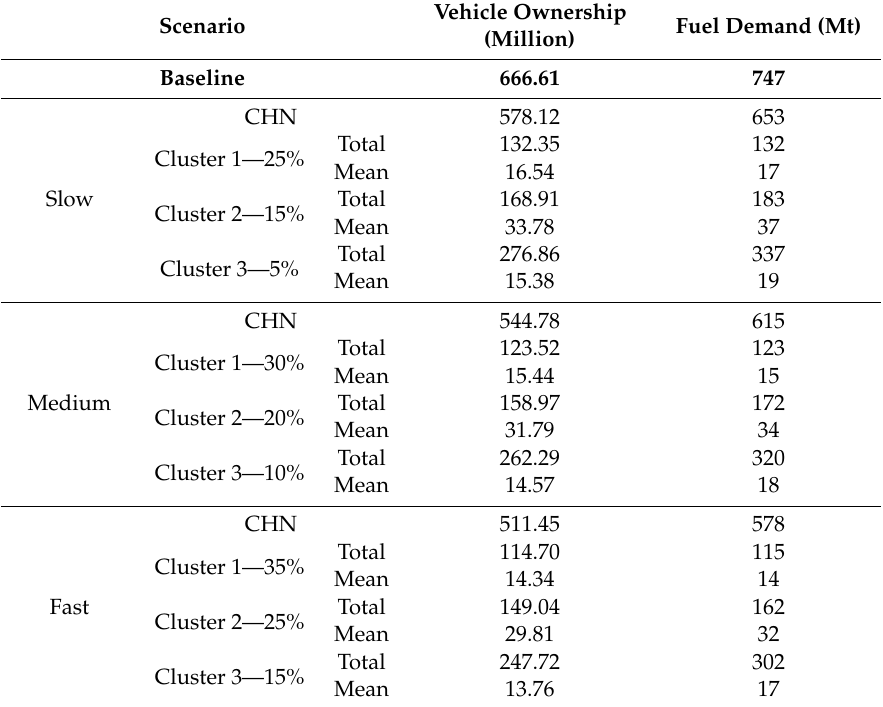
Table 10. Fuel vehicles and fuel demand under di ff erent substitution